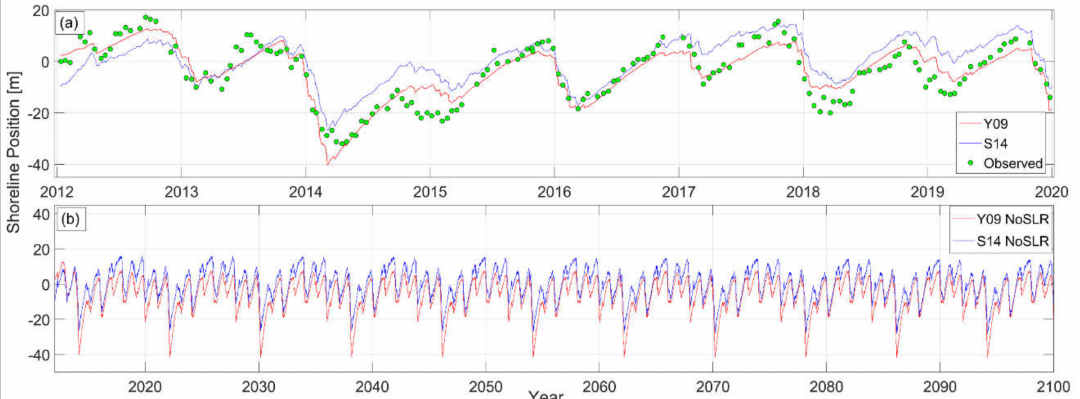
Figure 7. ( a ) Shoreline time series over the period 2012–2019. The red and blue lines represent the modeled shoreline obtained using Y09 and S14, respectively, and the green dots represent the mean shoreline position estimated from topographic surveys. ( b ) Modeled shoreline time series from 01 January 2012 to 31 December 2099 with no